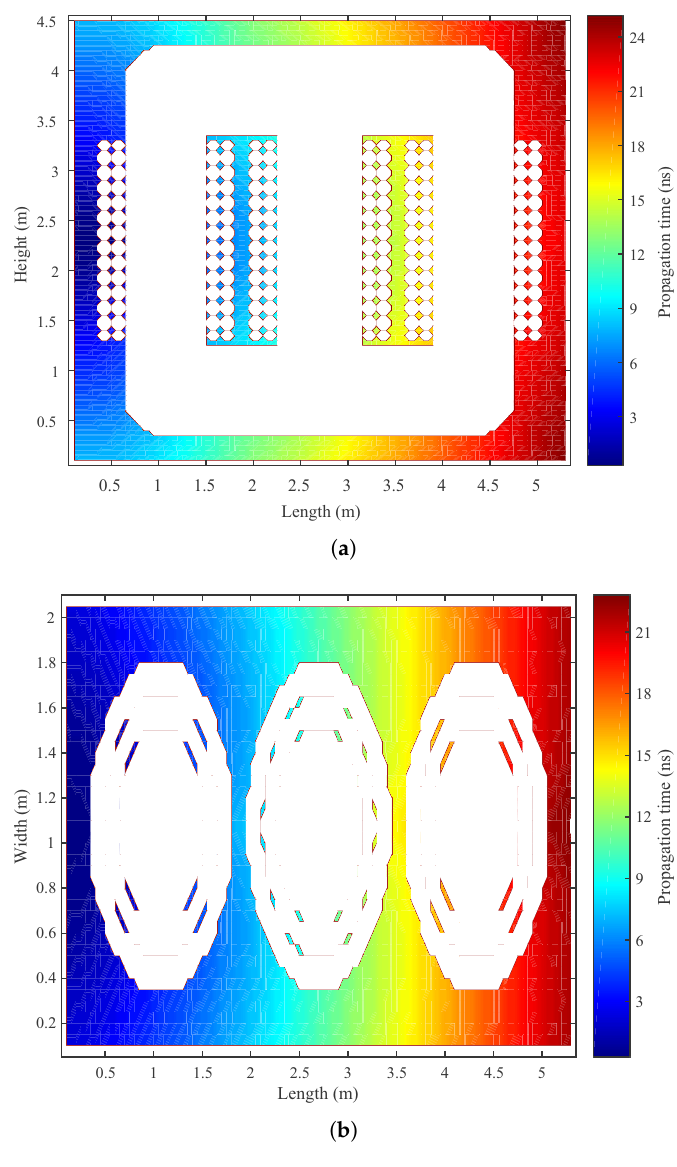
Figure 7. Signal propagation time to the sensor located on the left side of the equipment tank (sensor 1): ( a ) Longitudinal section along the central axis of the transformer, and ( b ) horizontal section along the central axis of the